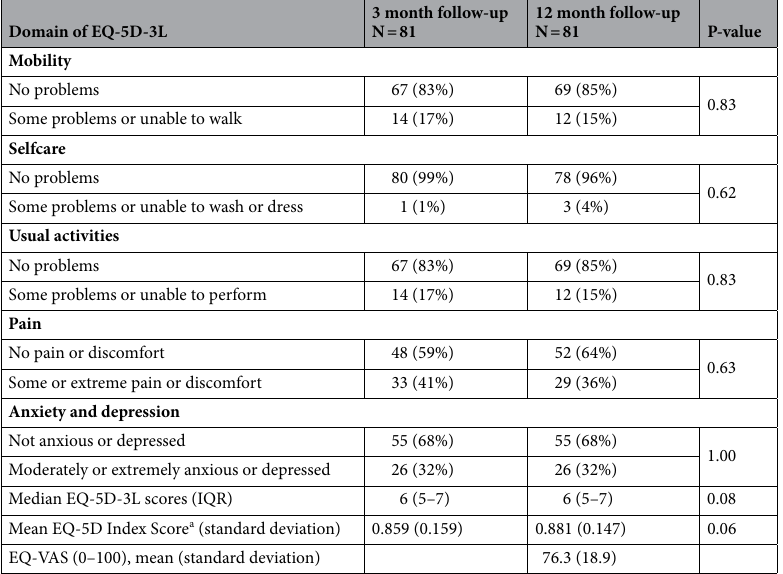
Table 1. Quality of life status (EQ-5D-3L) at 3 months and 12 months after COVID-19. EQ-5D-3L, EuroQol Group Association five-domain, three-level questionnaire; EQ-VAS, EuroQol visual analogue scale. a Health state index scores calculated from a Canadian value set 6